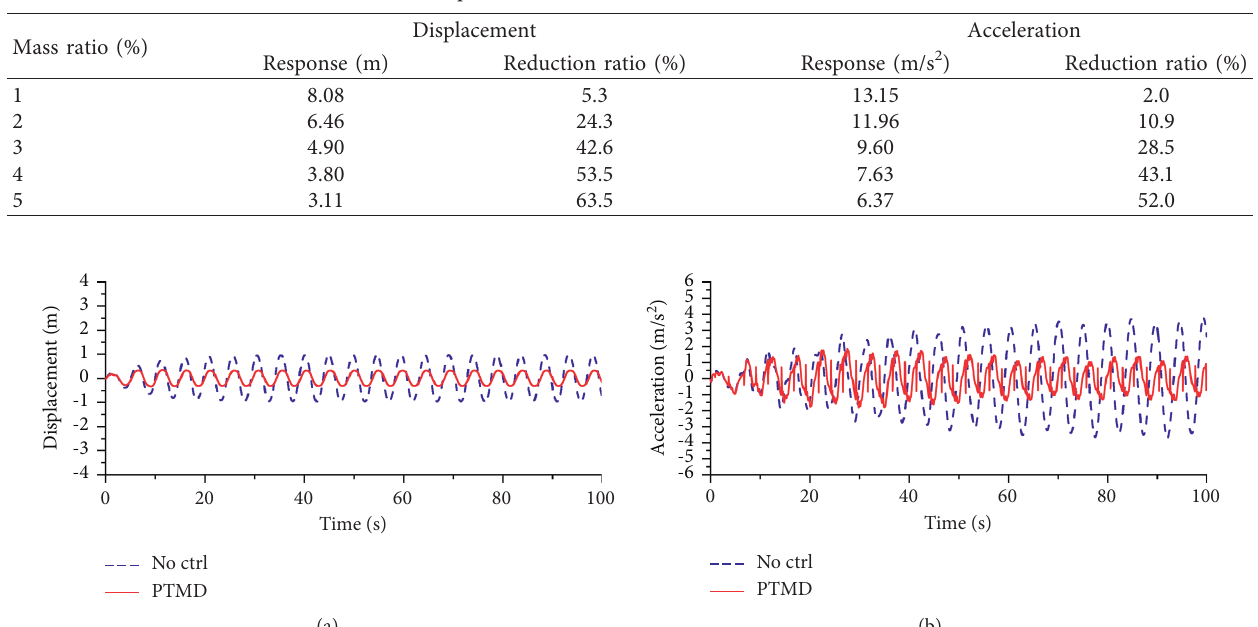
Figure 7: : Maximum response of the SCR under OC1: (a) displacement and (b) acceleration. Table 4: : Vibration control performance of the PTMD with different mass ratios under OC 4.